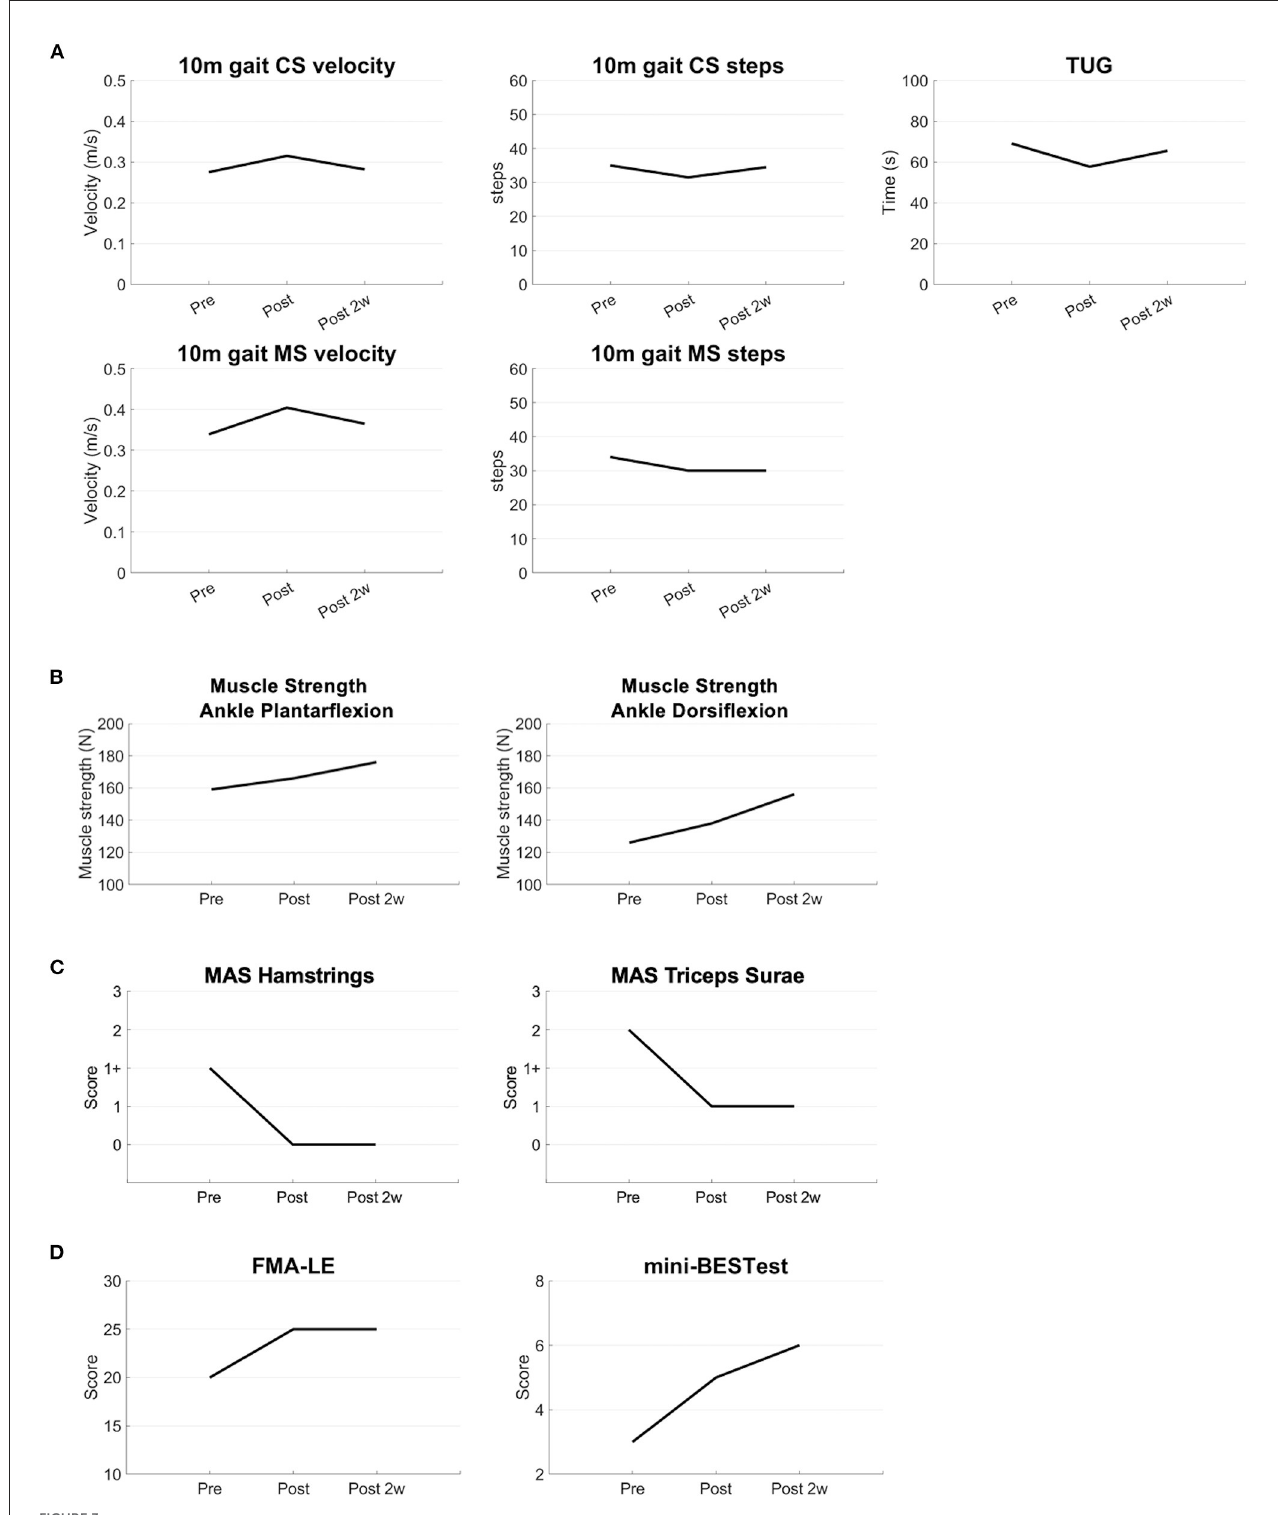
FIGURE3 Results of the long-term evaluations. The clinical parameters are shown before, immediately after, and 2 weeks after the intervention (A) The results of the 10m CS and MS gait tests show an increased velocity, decrease of the number of steps, and decrease of the time of the TUG test (B) Muscle strength of the ankle joint is increased after the intervention (C) MAS scores are lower after the intervention (D) FMA and mini-BESTest scores are improved after the intervention. CS, comfortable speed; MS, maximal speed; TUG, Timed Up and Go; MAS, modified Ashworth scale; FMA-LE, Fugl-Meyer Assessment Lower Extremity; mini-BESTest, mini-Balance Evaluation Systems